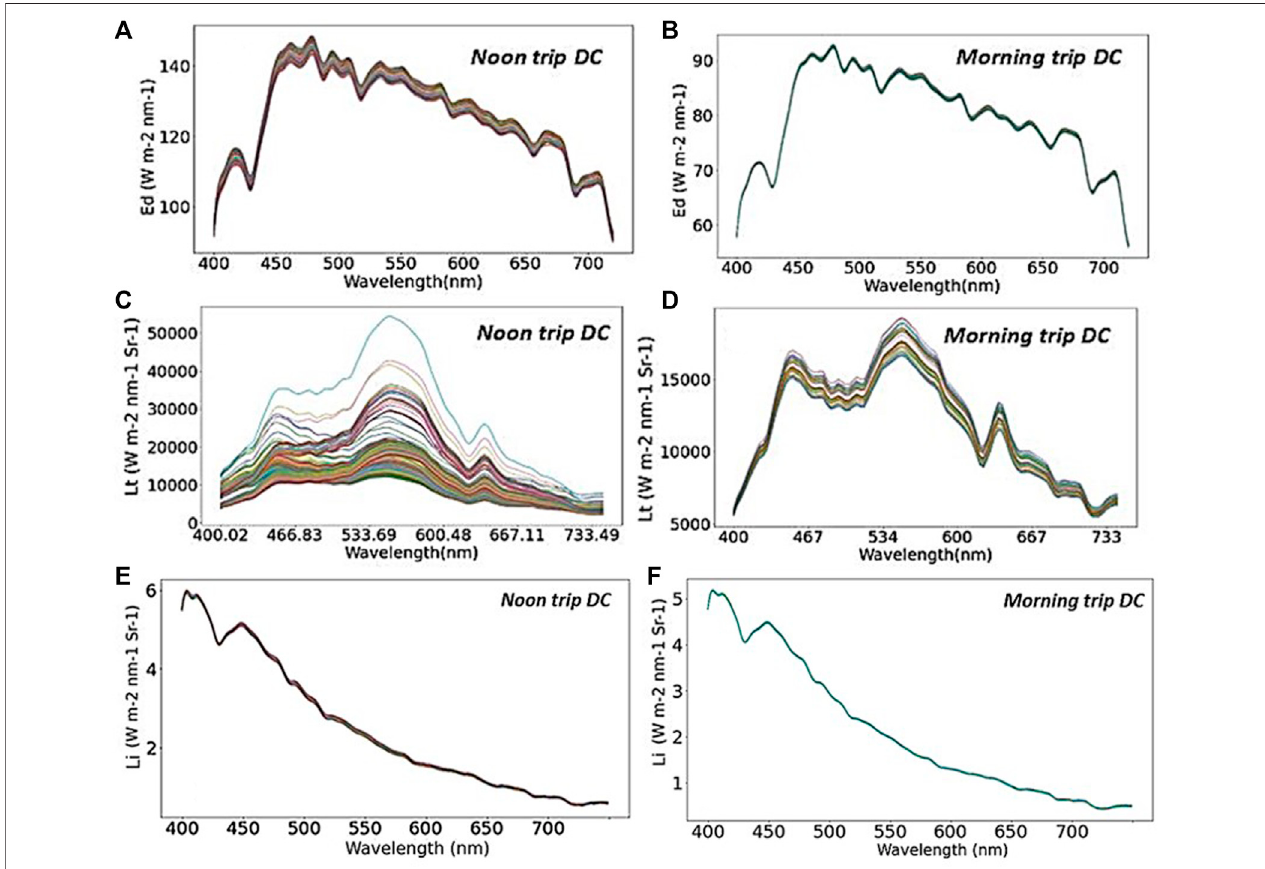
FIGURE 4 | Comparison of radiometric quantities — downwelling irradiance (E d ) (A,B) , total sea surface radiance (L t ) (C,D) , sky radiance (L i ) (E,F) for morning trip and noon trip data collection by SAS-ST installed on the ferry Queen of Alberni on 16 June 2019.